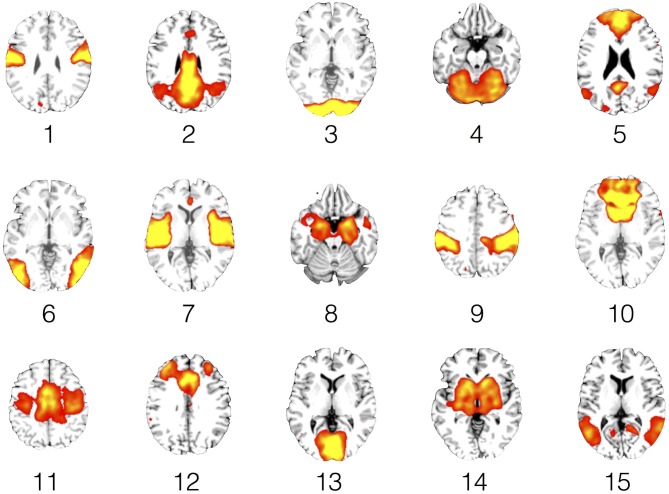
Resting state networks (RSNs). This figure shows representative slices for each of the 15 RSNs. The functional connectivity maps are rendered as 1-sample t-tests (p < 0.05, family wise error (FWE) corrected for comparing across the whole brain) across the entire study sample of narcolepsy patients and healthy controls.